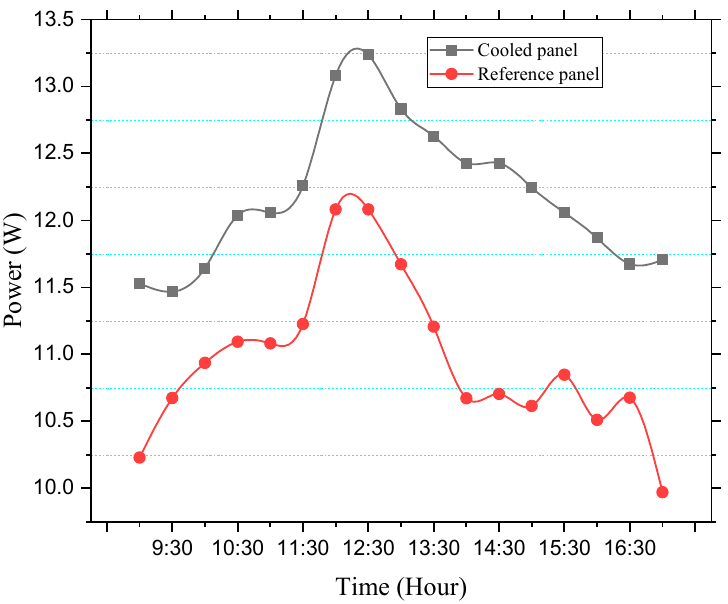
Figure 10. Power output for the cooled and referenced modules.